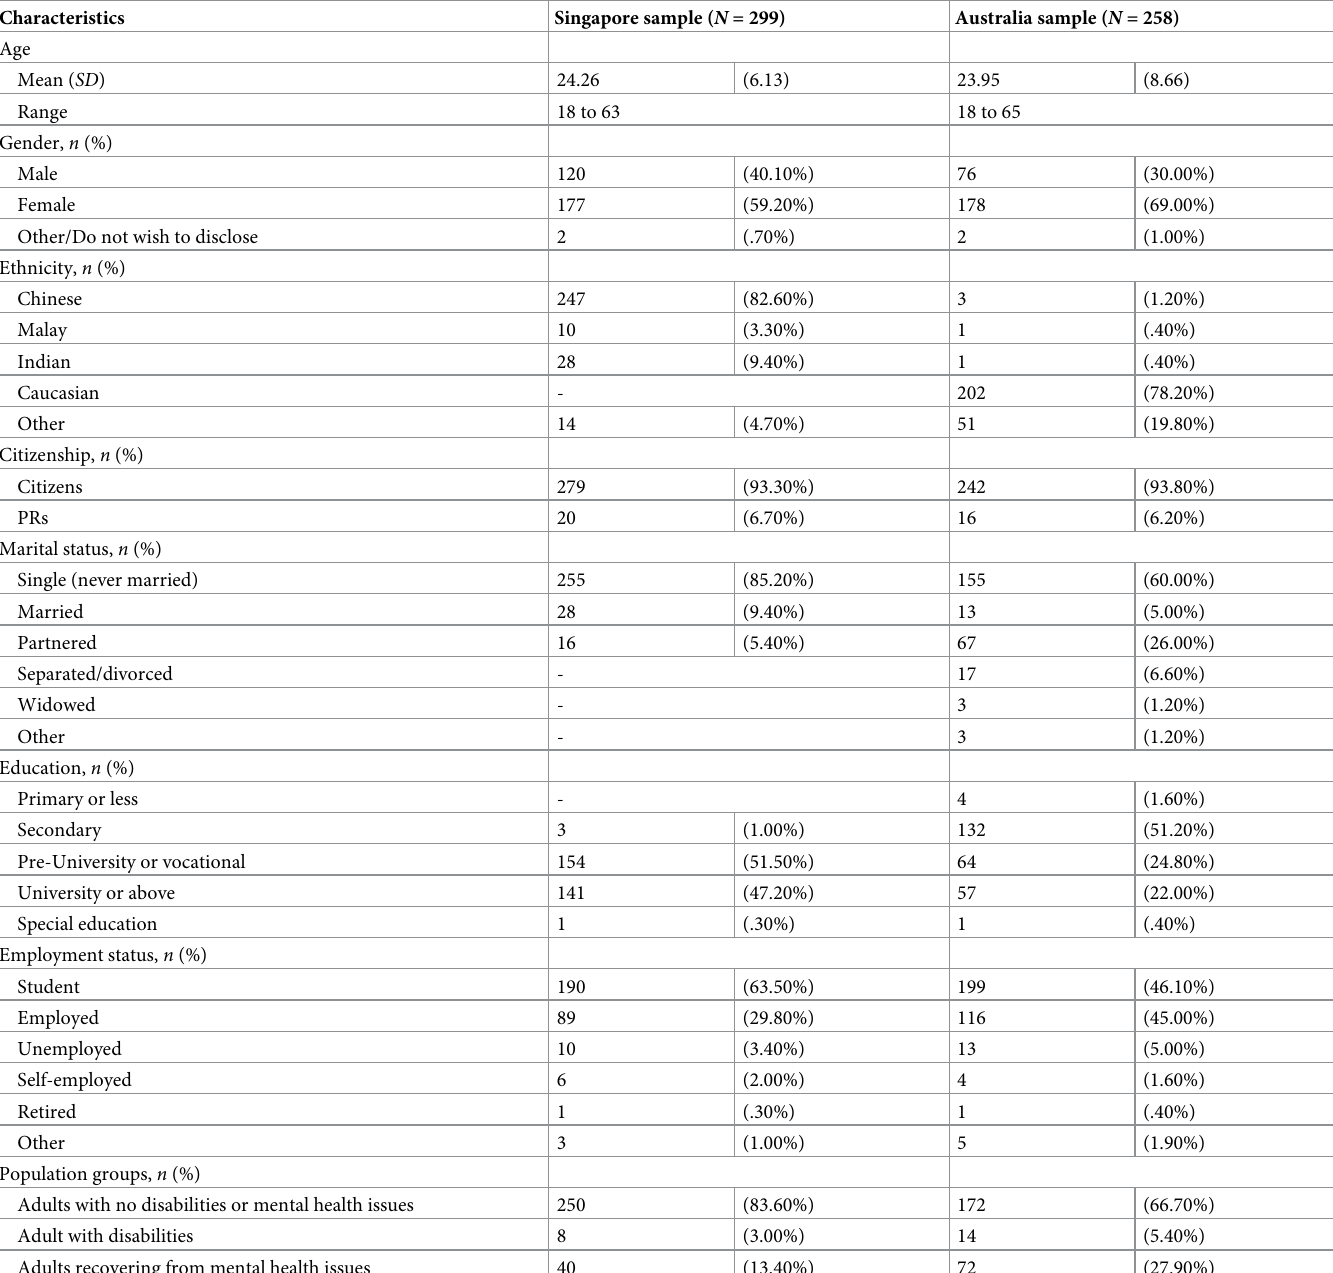
Table 2. Characteristics of